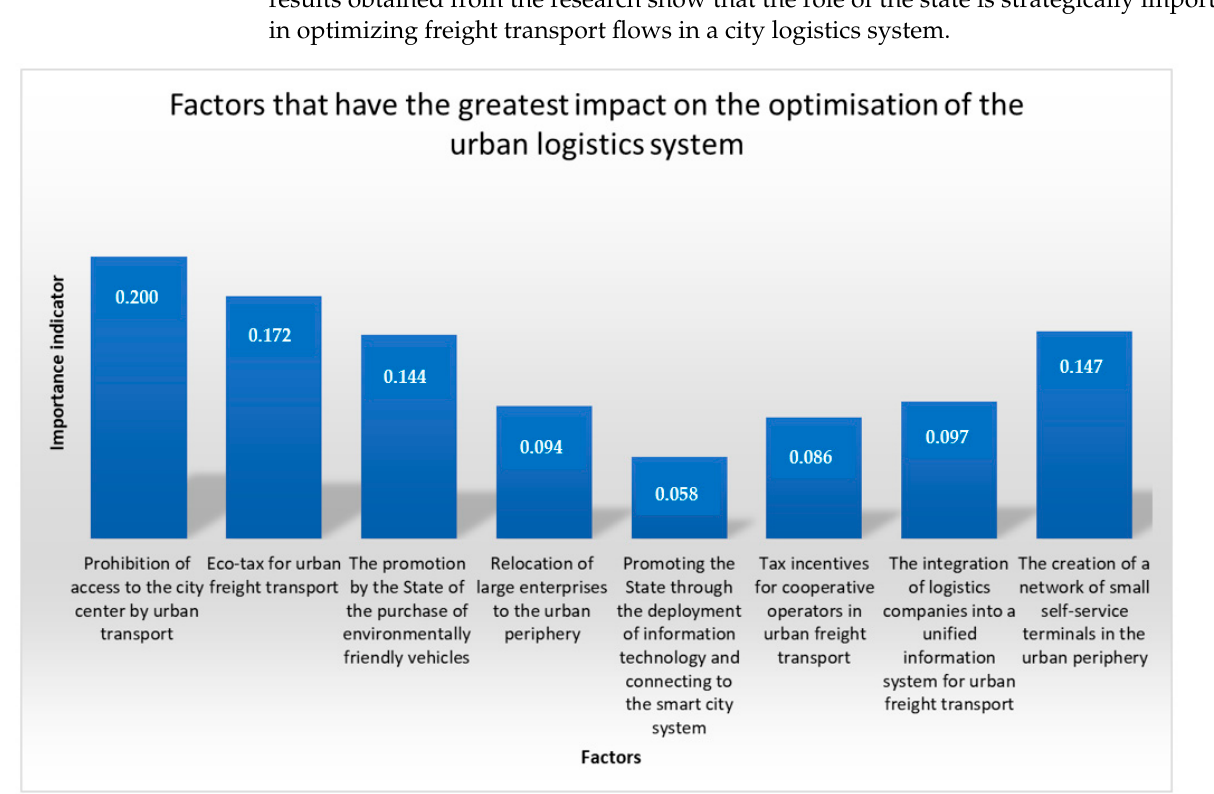
Figure 2. Factors that have the greatest impact on the optimization of an urban logistics system.